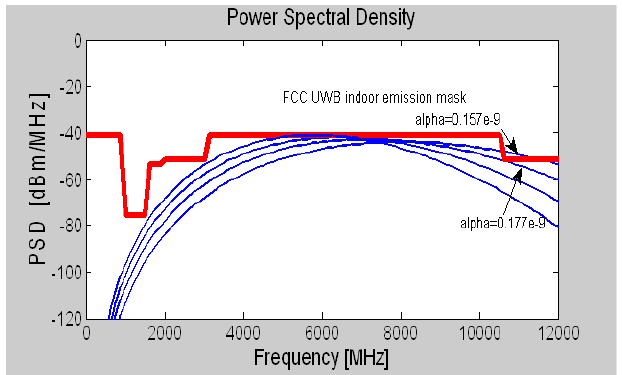
Fig.9. Optimal pulse shape Power Spectral Density Fig.8. shows the generated optimal pulse using proposed approach using optimal values of [0.1162e-9,